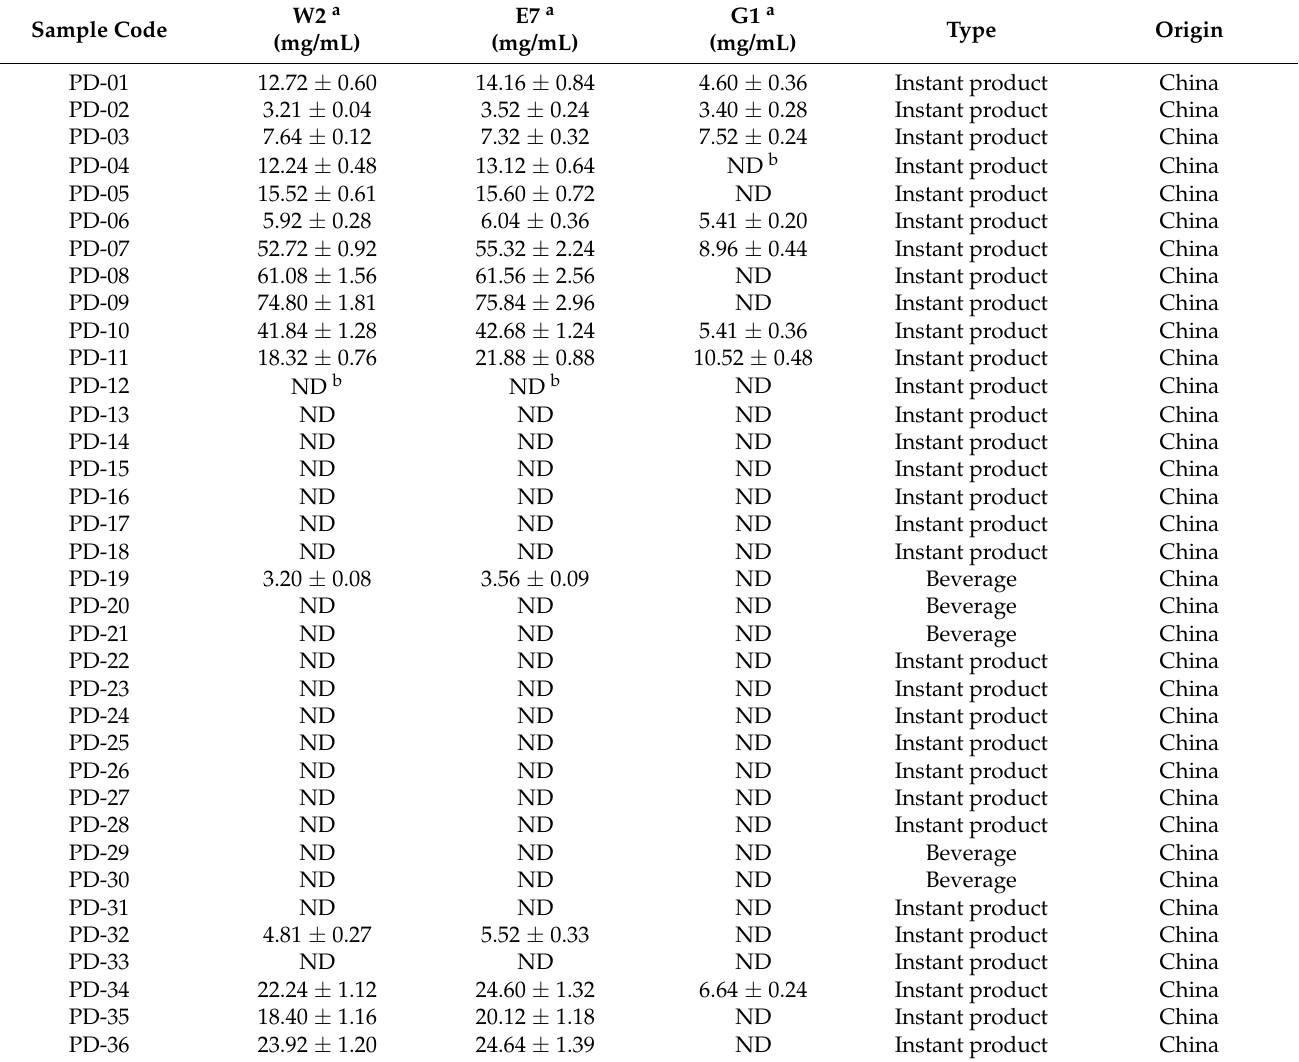
Figure 4. Linearity relationship between the total protein amount/raw material amount and the peak area of specific peptide markers including white EBN specific marker 2 (W2, m/z 454.7081), EBN-specific marker 7 (E7, m/z 498.8056) and grass EBN-specific marker 1 (G1, m/z 447.6998). Table 4. Quantitative analysis of EBN, white EBN, and grass EBN in commercial EBN liquid products.